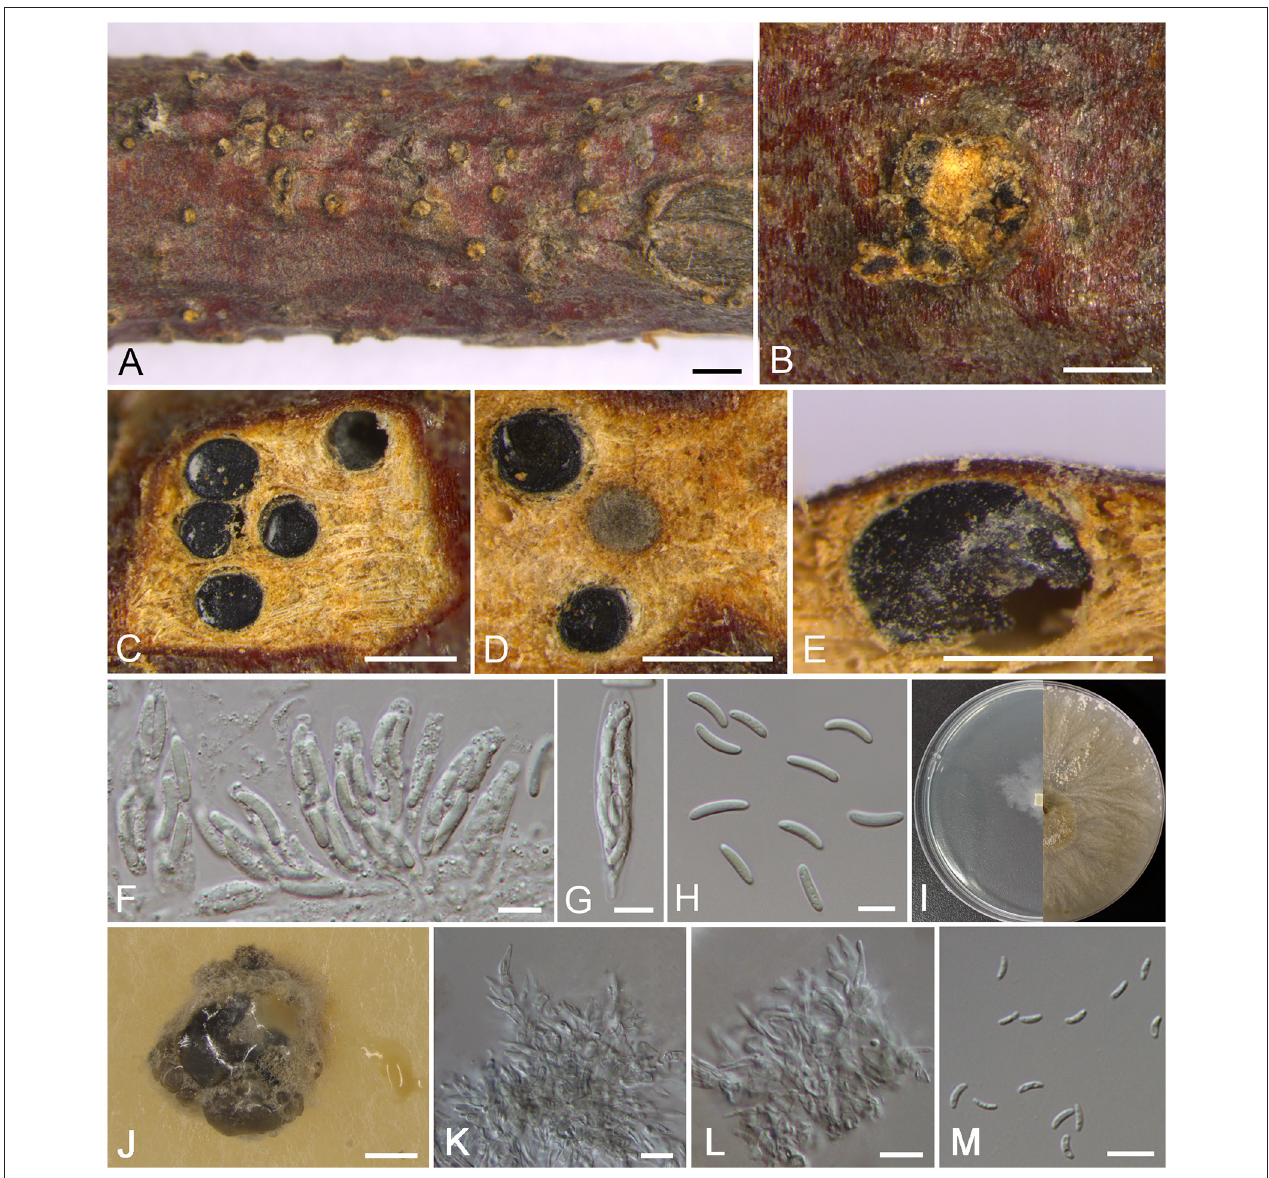
FIGURE 4 | Morphology of Cytospora donglingensis (BJFC CF2019884). (A,B) Habit of ascomata on twig. (C,D) Transverse section of ascomata. (E) Longitudinal section through ascomata. (F) Asci and ascospores. (G) Ascus. (H) Ascospores. (I) Colonies on PDA at 3 days (left) and 30 days (right). (J) Conidiomata from culture on PDA. (K,L) Conidiophores. (M) Conidia. Bars: (A) = 1mm; (B–E), (J) = 500 µ m; (F–H), (K–M) = 10 µ m.